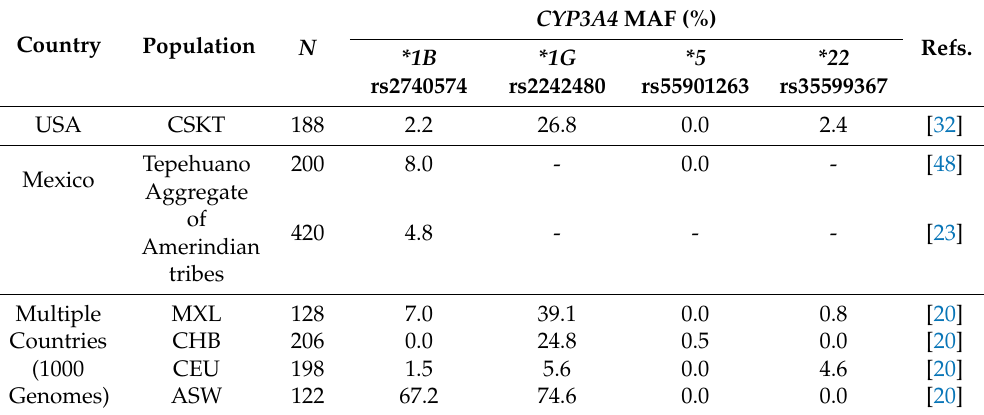
Table 11. Comparison of CYP3A4 allele frequencies Indigenous North American populations to global populations from the 1000 Genomes Project [20]. N represents the number of alleles. Not shown are CYP3A4*2 (rs55785340), CYP3A4*4 (rs55951658) and CYP3A4*8 (72552799), as these variants were